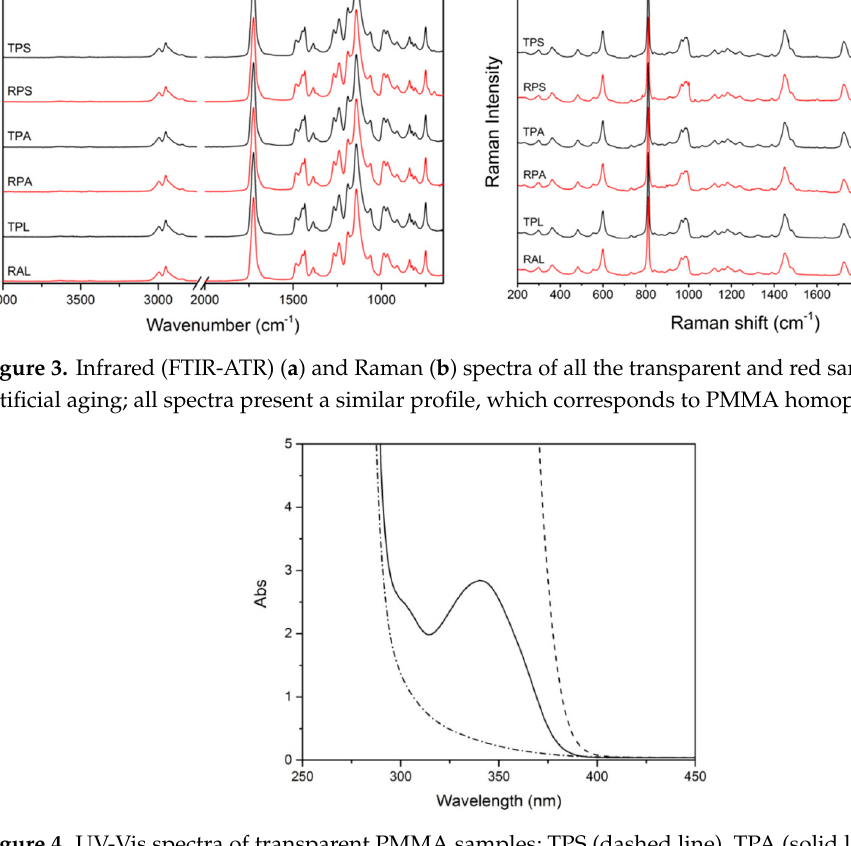
Figure 4. UV-Vis spectra of transparent PMMA samples; TPS (dashed line), TPA (solid line) and TPL (dash-pointed line) before artificial aging.